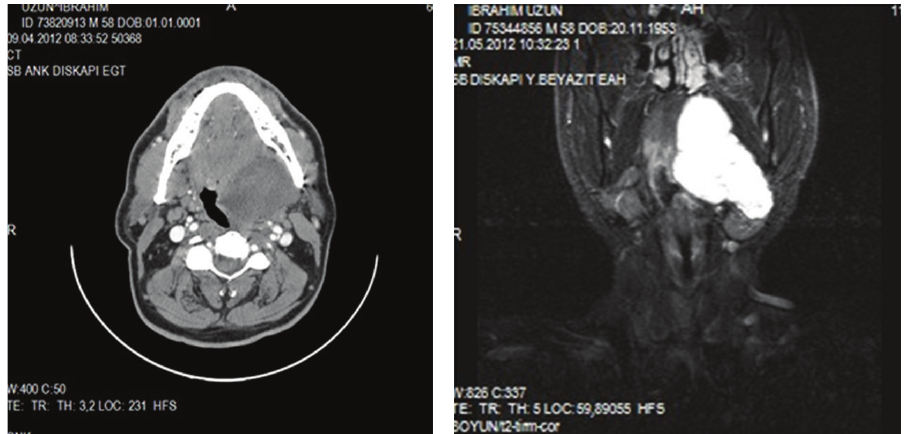
Figure 1: Preoperative CT scan and MRI demonstrate a hyperintense mass.